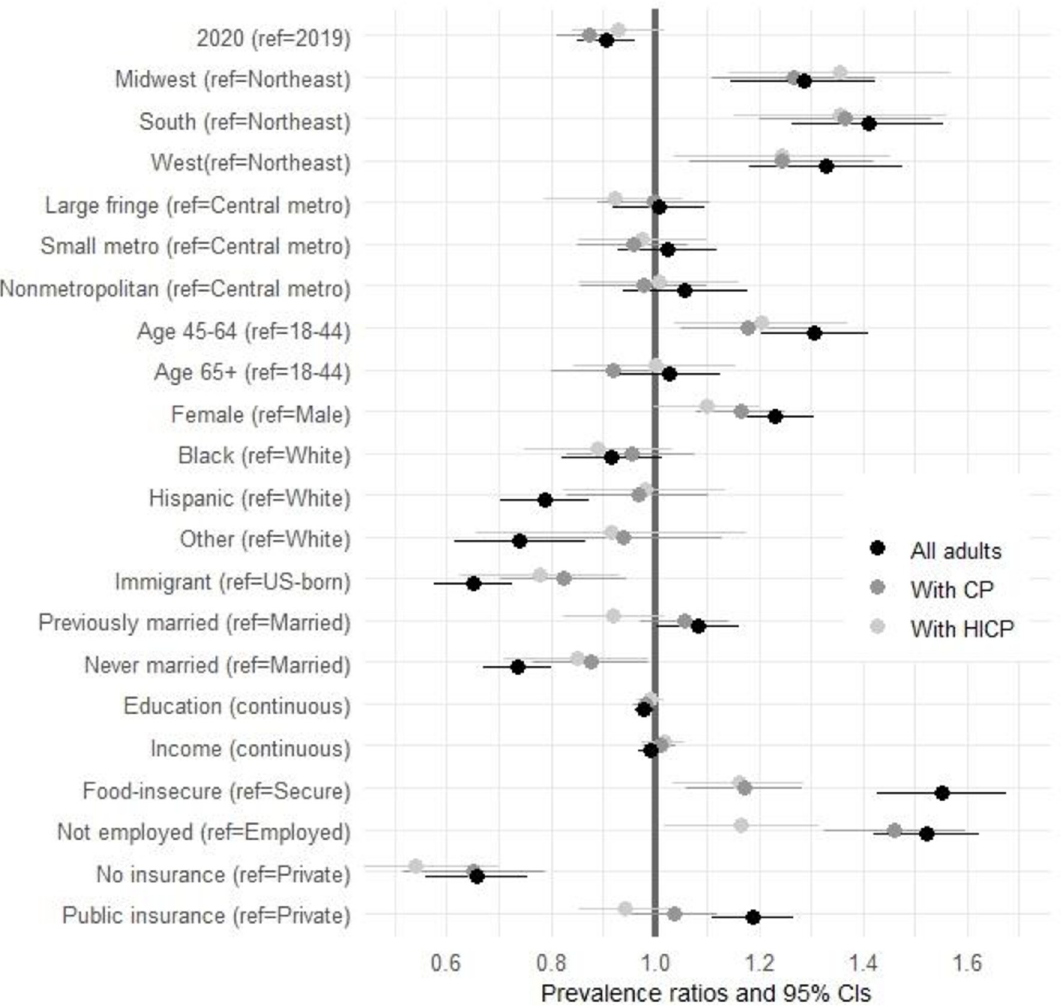
Fig 2. Coefficient plot showing the association between all covariates and prescription opioid use in fully-adjusted models, for three subsamples: All adults, adults with chronic pain, and adults with high-impact chronic pain. The plot shows prevalence ratios and their 95% confidence intervals from fully-adjusted robust Poisson models of prescription opioid use estimated separately for the three subsamples of all adults, adults with CP, and adults with HICP. The omitted category for each categorical predictor is in parentheses. CP = chronic pain; HICP = high-impact chronic pain; metro = metropolitan